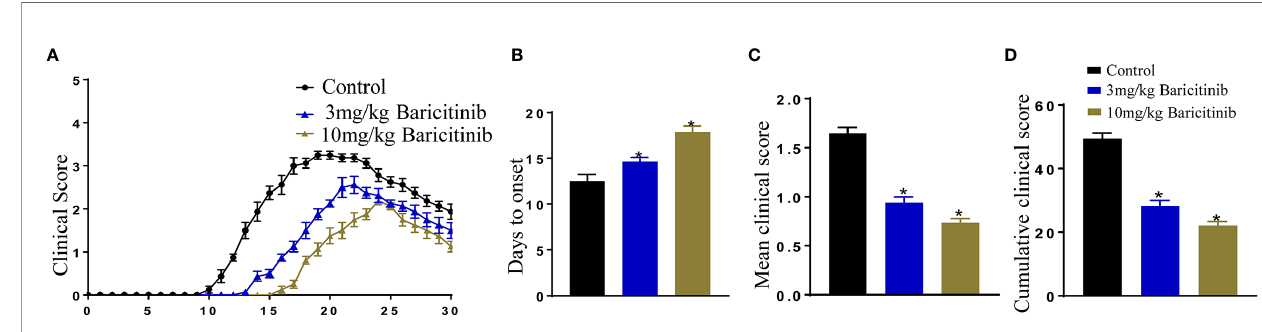
FIGURE 1 | Baricitinib delays and attenuates the symptoms of experimental autoimmune encephalomyelitis (EAE) in mice. Mice were injected with MOG35-55 peptide to establish the EAE model and received an injection of either baricitinib or vehicle. Day 0 is EAE induction. (A) The clinical symptom scores of the mice in the different groups after EAE induction. In the baricitinib-treated groups, the clinical signs were remarkably mild. The clinical scores were remarkably better in the baricitinib-treated groups than in the control group from day 10 to 30. (B) Baricitinib delayed the onset of disease in the baricitinib-treated groups. (C) The mean score for mice in each group was recorded every day over a 30 d period. Baricitinib improved the mean clinical score in mice with EAE. (D) The mean cumulative clinical score of vehicle-treated mice was signi fi cantly greater than that of baricitinib-treated mice (sum of scores = 30 d). Quantitative data are the mean ± SEM. * p < 0.05; n = 8 per group. SEM, standard error of the mean.